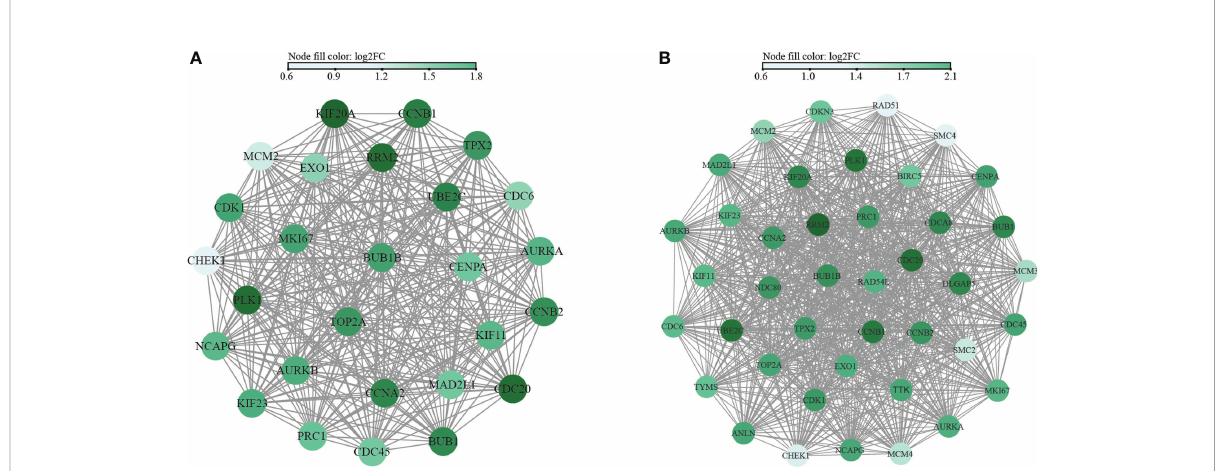
FIGURE 8 Network interaction diagram of hub genes in M1CM (A) and M2CM (B) groups. The nodes represent the hub genes, and the edges represent the protein protein interaction. The color is determined by the results of the six indicators from large to small, and the greater the score, the darker is the